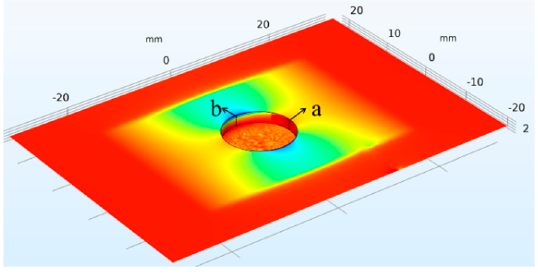
Figure 13. Current density distribution corresponding to the inner surface of the volumetric corrosion Figure13. pit.